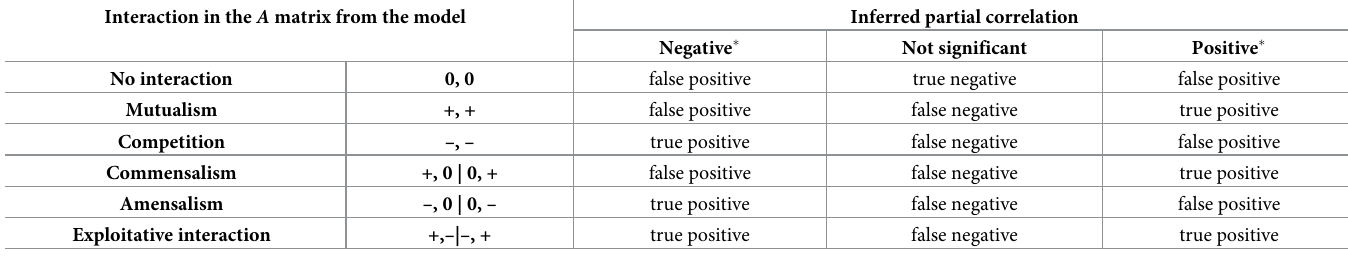
Table 1. The confusion matrix as used in this study. The inferred partial correlation coefficient ρ (from the lower part of the partial correlation matrix) must have the same sign as one of the interactions in the interaction matrix A to be considered as a true positive finding in base case analysis. Interaction in the A matrix from the